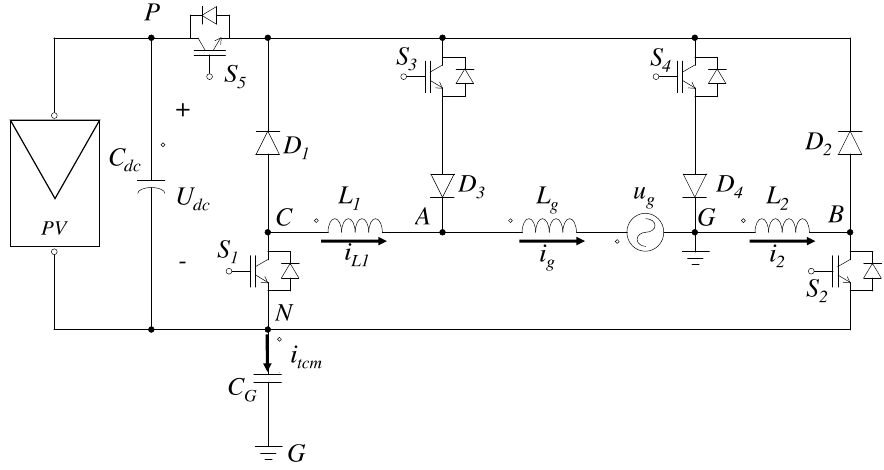
Figure 9. Circuit topology of the proposed TDFGI-H5 in Reference